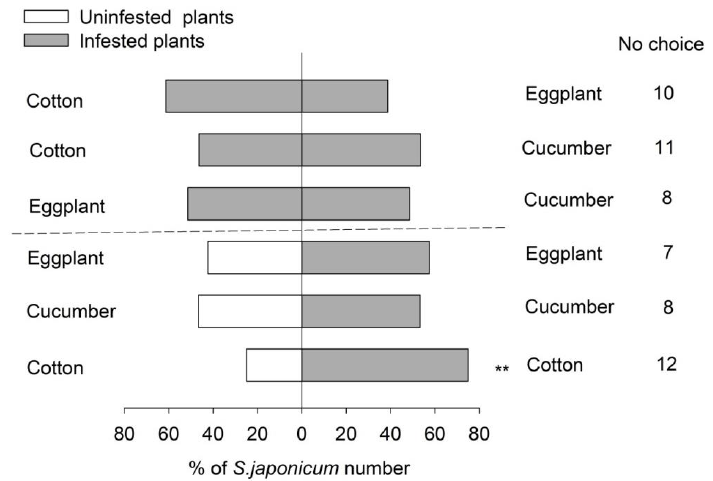
Figure 5. Two-choice assays of Serangium japonicum by Y-tube olfactometer. No choice means that the ladybeetles did not respond in the allotted time. Significance was analyzed in each group at p < 0.05. ** Represents values that were statistically significant at 0.01 > p > 0.001.